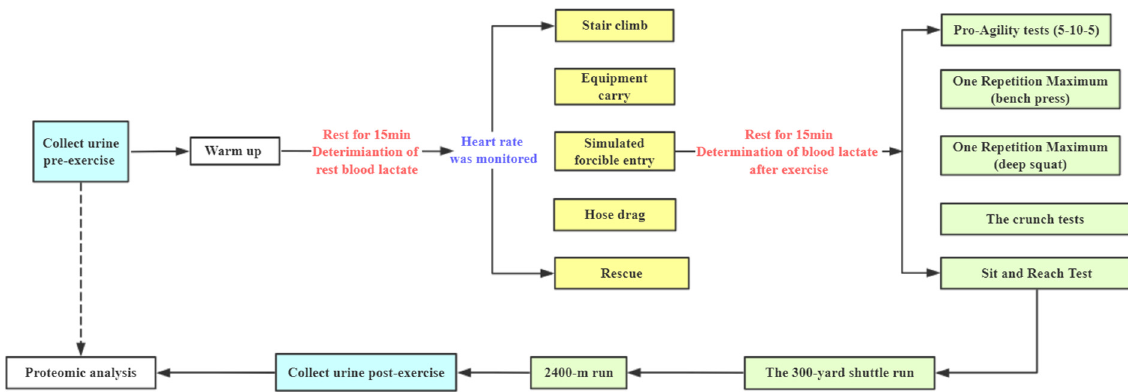
Figure 1. Flowchart of the combined simulated firefighting tasks